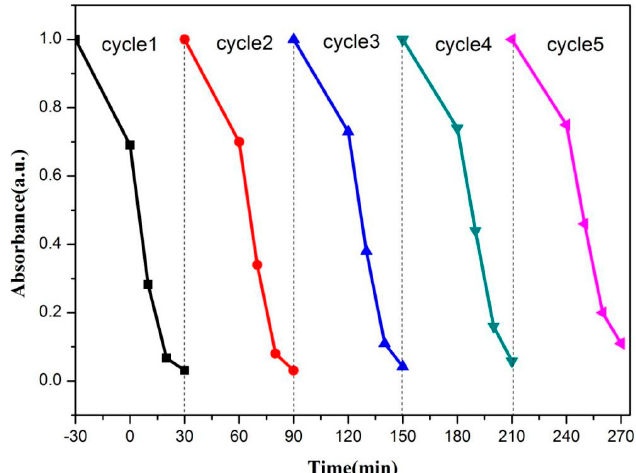
Figure 7. Cycling tests of photocatalytic degradation Rhodamine B (RhB) in BOB/SFO-5 under visible light irradiation.